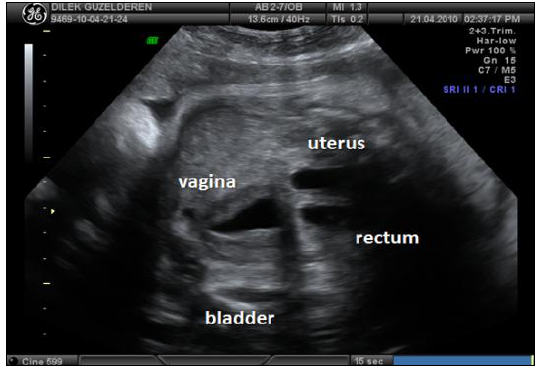
Figure 2B: Left hydronephrotic kidney (white Figure 1B: Two fusiform cystic masses were arrow heads) was demonstrated in fetal MRI appeared during the scan just behind the pubic while right fossa renalis (white asterix) was cystic mass described in Figure 1 A. The walls empty. However, just behind the spine, a struc- of these 2 structures were less thick than the ture with a similar appearance to a dysplastic, former. slightly distorted right kidney was reported (white empty arrow). Hydrometrocolposis was clearly visualized by fetal MRI (white